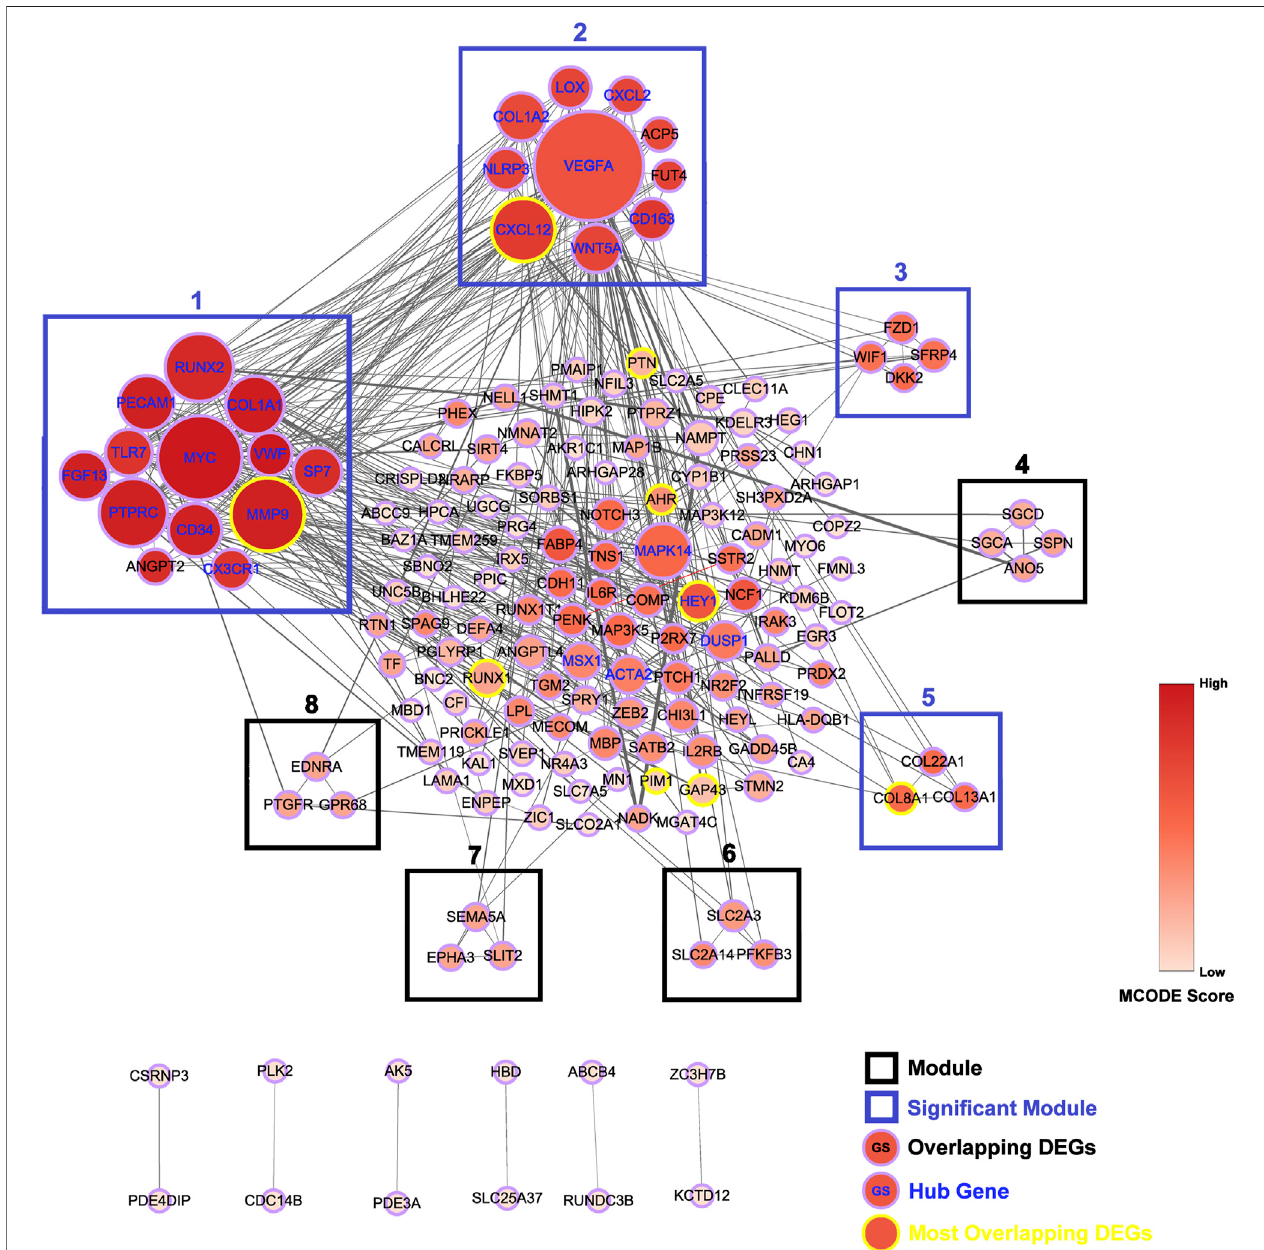
FIGURE 3 | Construction of protein-protein interaction (PPI) network. PPI network for all the overlapping DEGs is constructed and followed by module analysis on Cytoscape platform. Genes with yellow border are most overlapping DEGs and genes with blue gene symbol are hub genes. Modules with blue border are signi fi cant modules. The size of circles re fl ects the degree of connectivity. The shades of color re fl ect MCODE score.